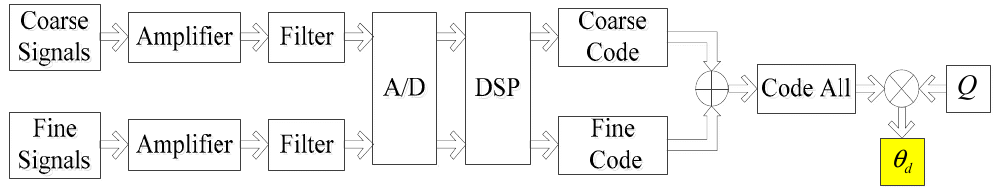
Figure 7. Internal structure of the photoelectric angle encoder.